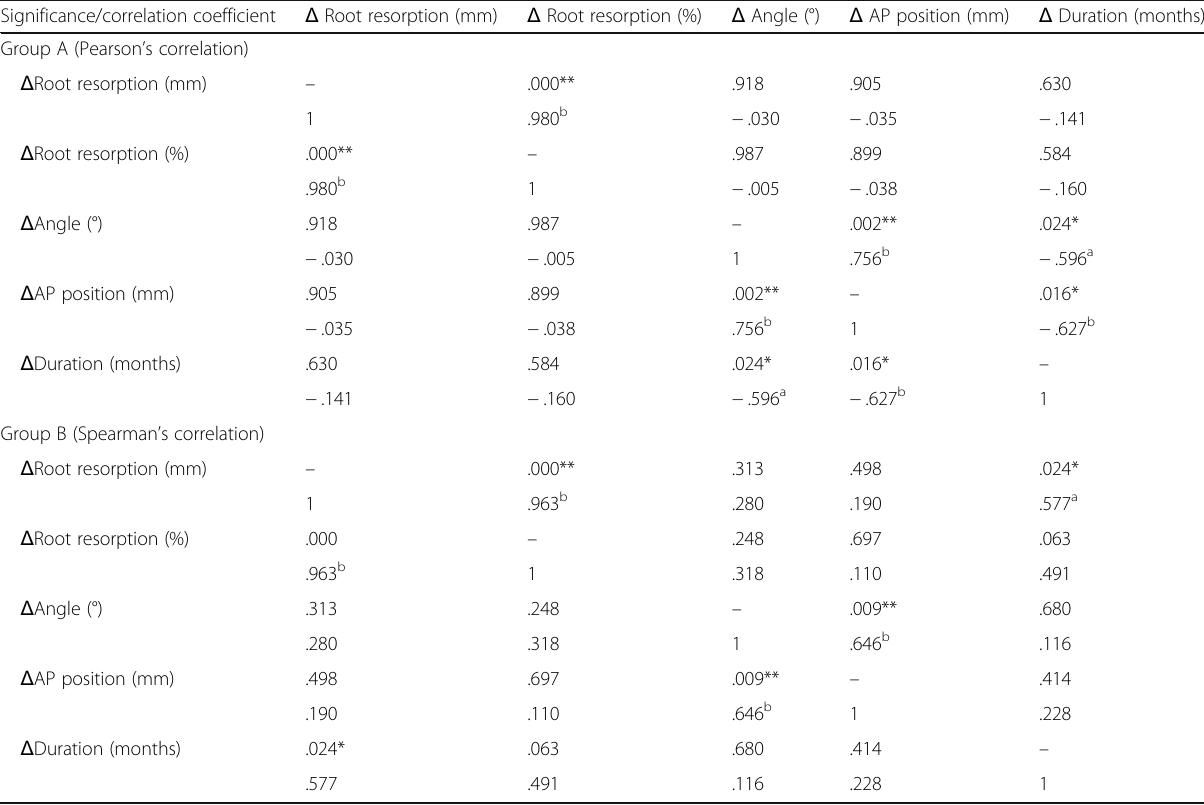
Table 3 The correlation between variables in each group Significance/correlation